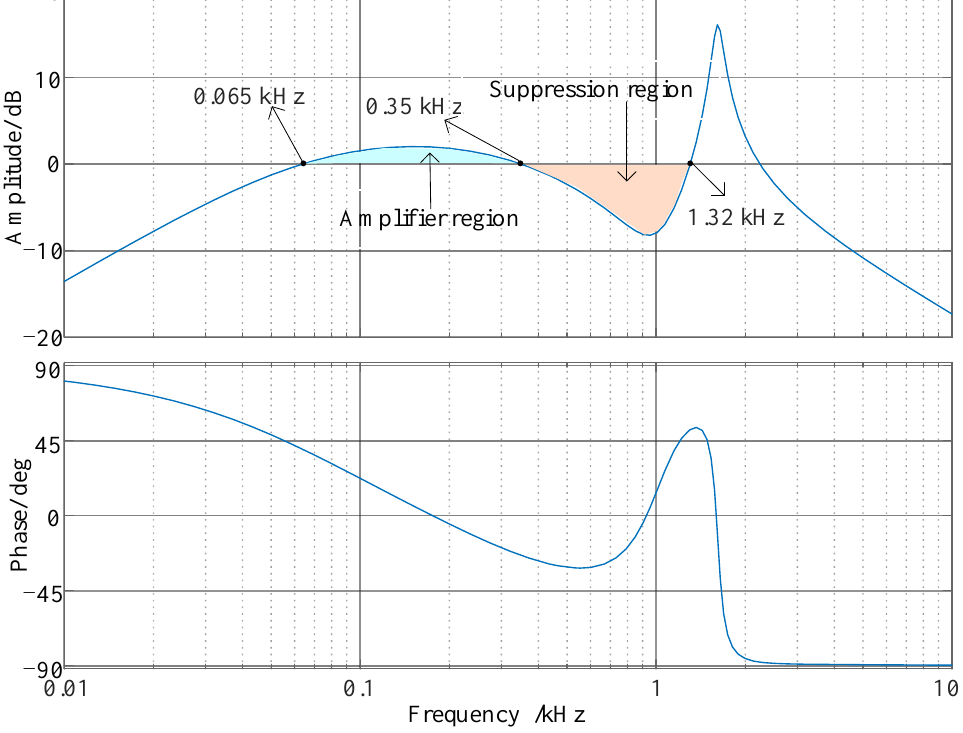
whose 6th harmonic frequency is less than 0.38